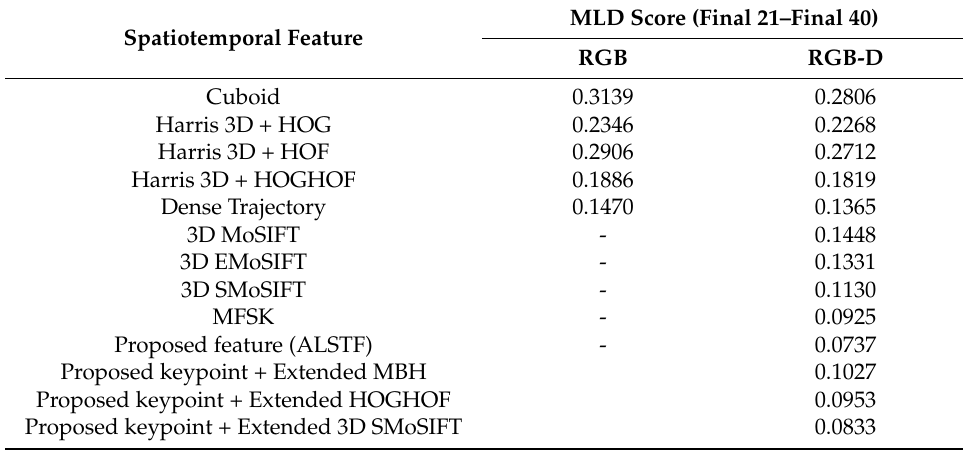
Table 4. The performance comparison of different spatiotemporal feature approaches on the final batch (round 2: final 21–final